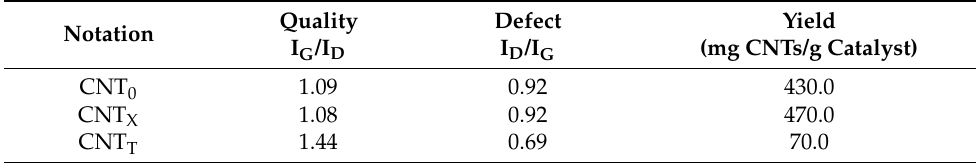
Figure 7. Raman spectra of as-produced CNMs: CNT X ( A ), CNT 0 ( B ) and CNT T ( C ). Table 4. Yield and quality of all synthesized CNMs.